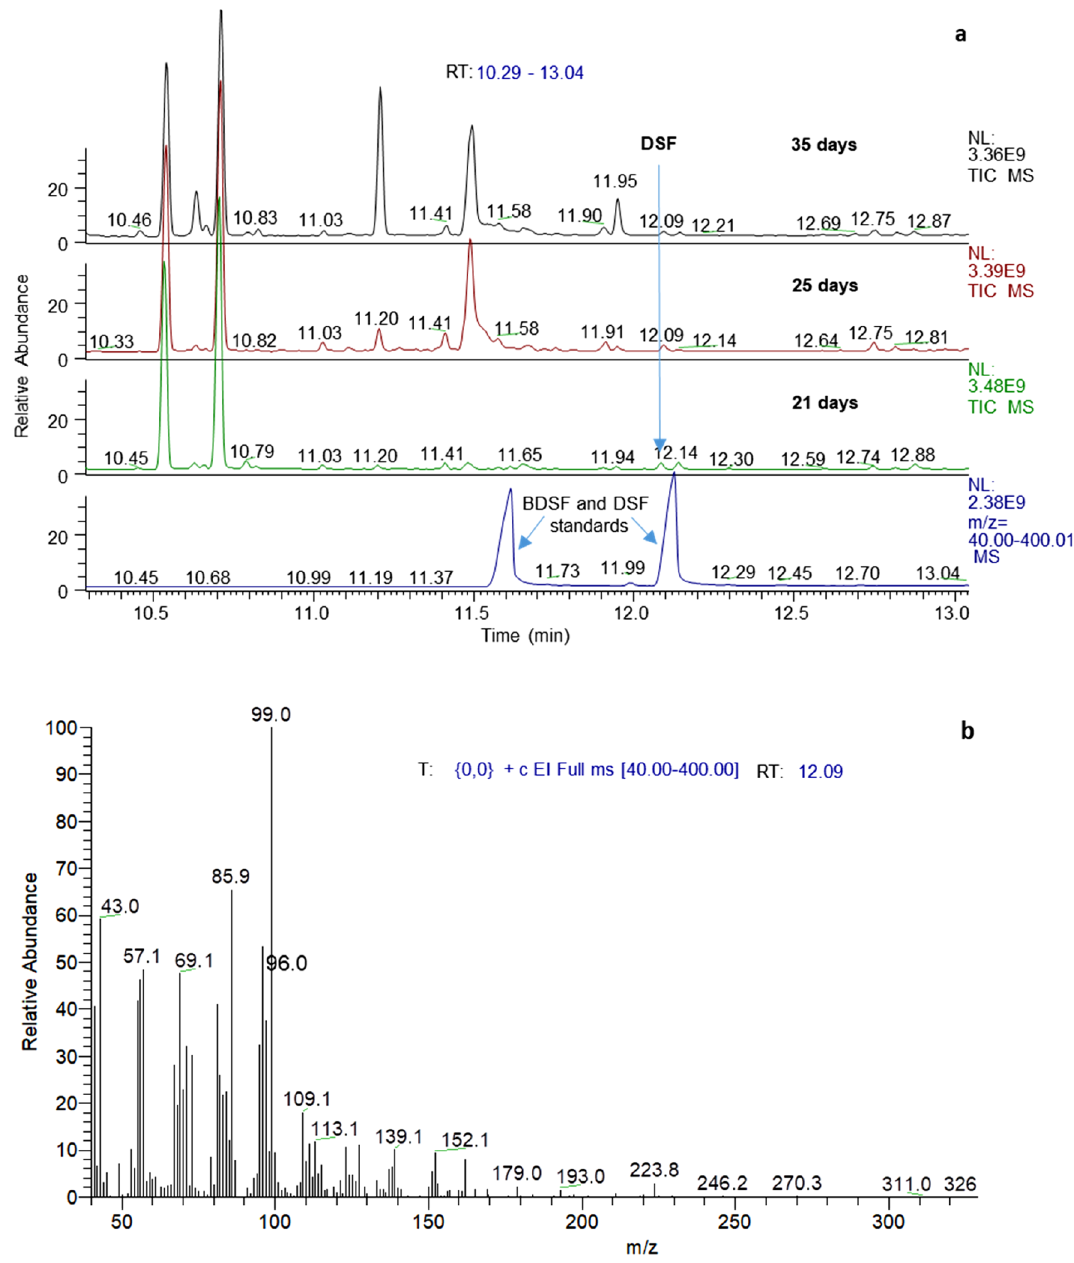
Figure 3. GC–MS analysis of culture extracts for identification of biogenic DSF. Total ion chromatograms of extracts from 21, 25, and 35 days old L. ferrooxidans T ( a ) and L. ferriphilum DSM T ( c ) pyrite cultures measured by GC–MS. The mass spectrum at the inferred retention time of DSF (12.09 min) confirmed the presence of the biogenic substance in pyrite culture supernatants of L. ferrooxidans T ( b ) and L. ferriphilum T ( d